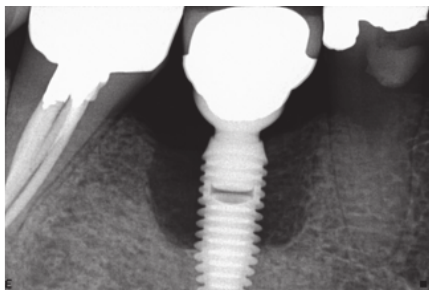
Figure 21: One year following treatment. Minimal to no improve- ment following surgical treatment.